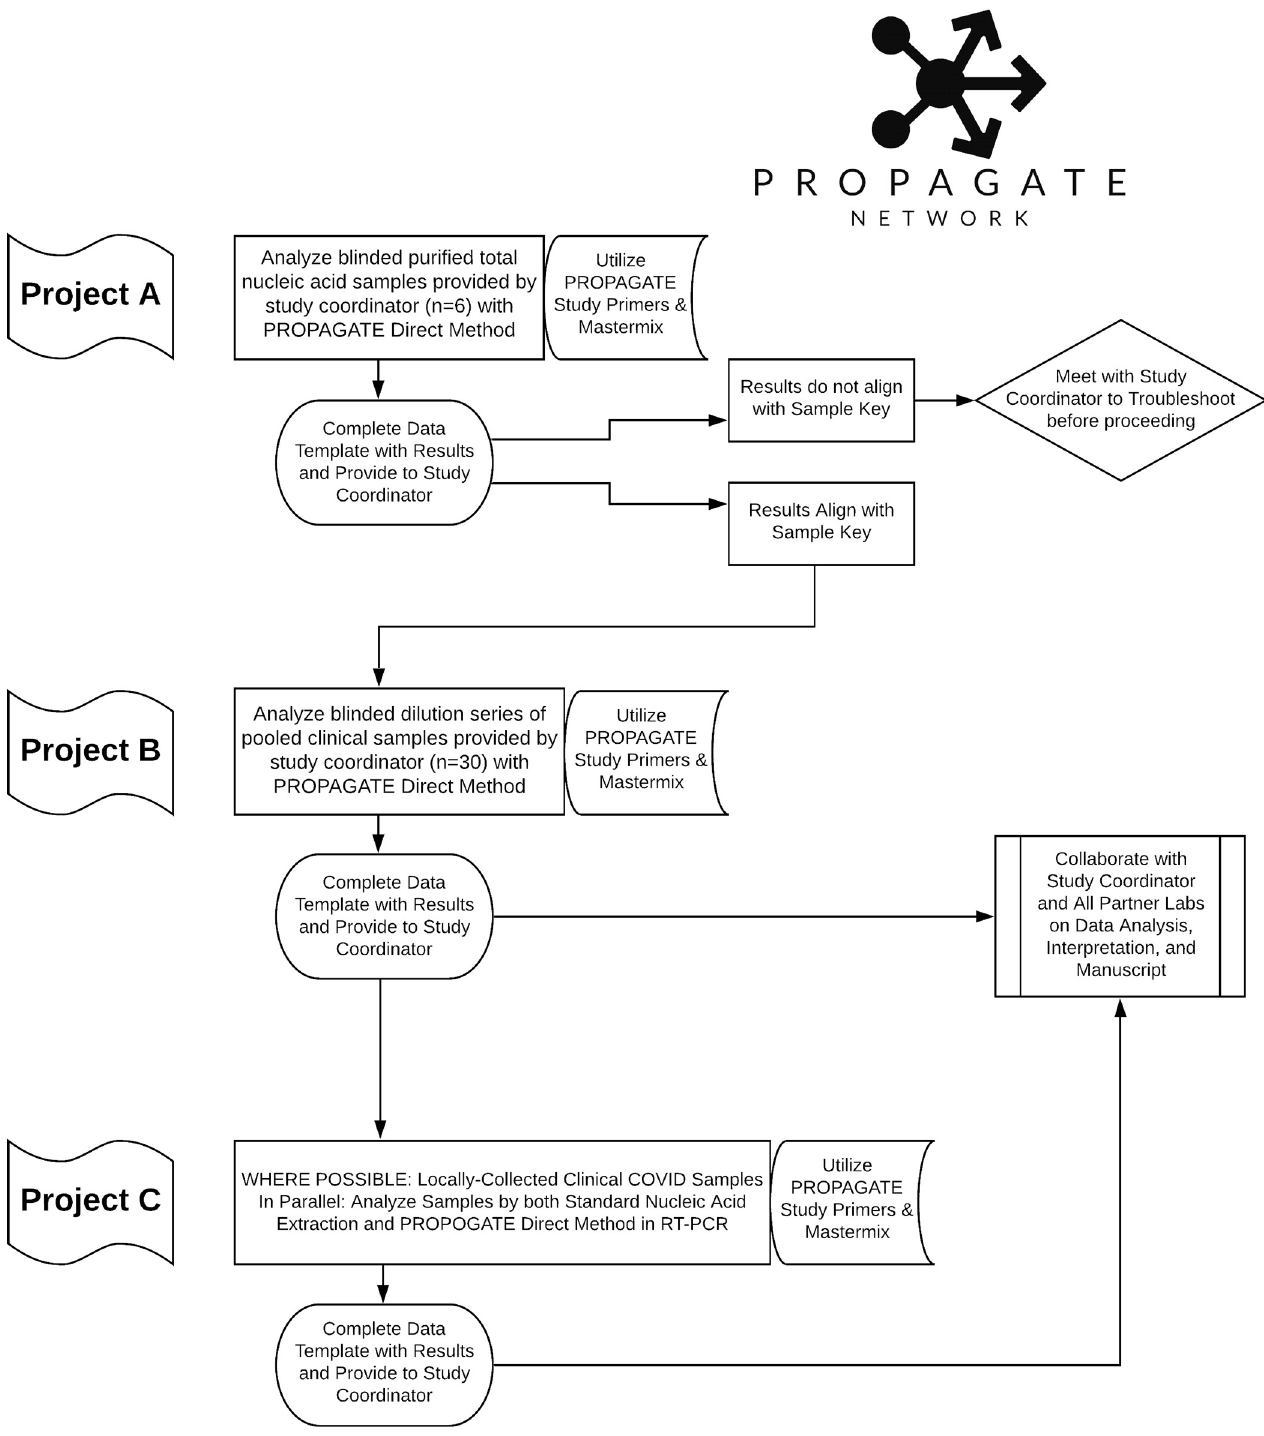
Fig 1. Study design for the Propagate Network.